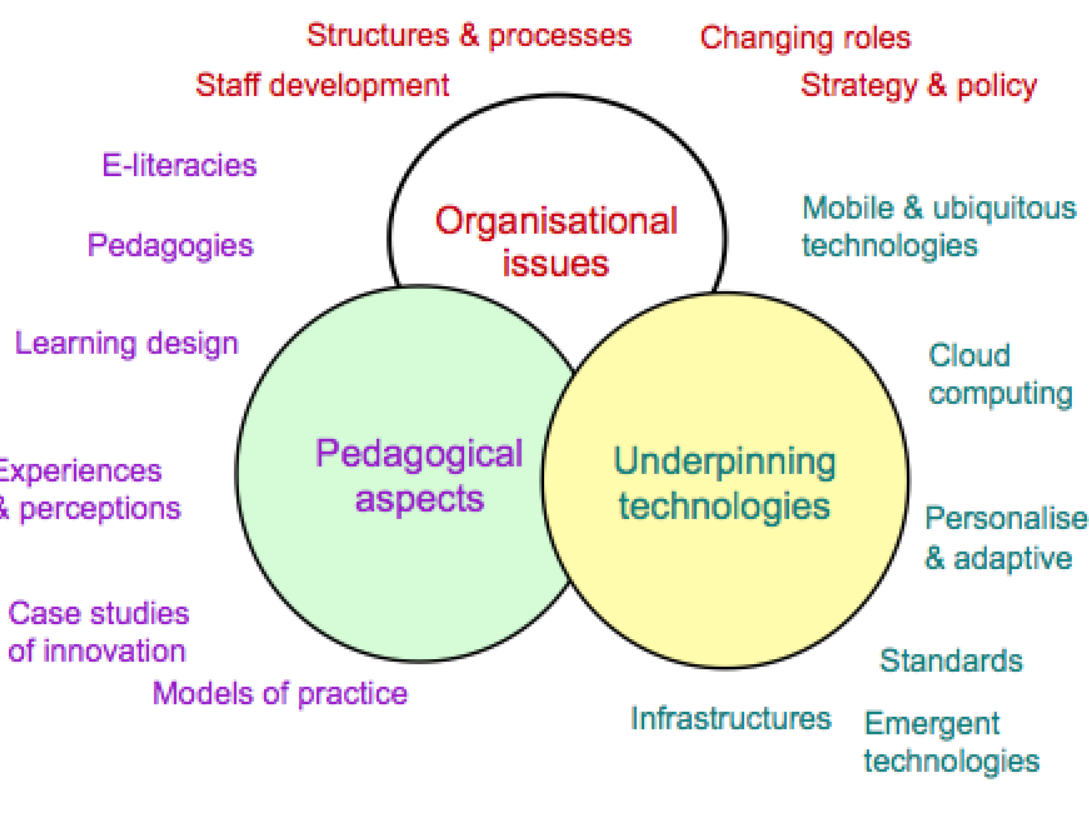
Figure 4: Facets of digital learning